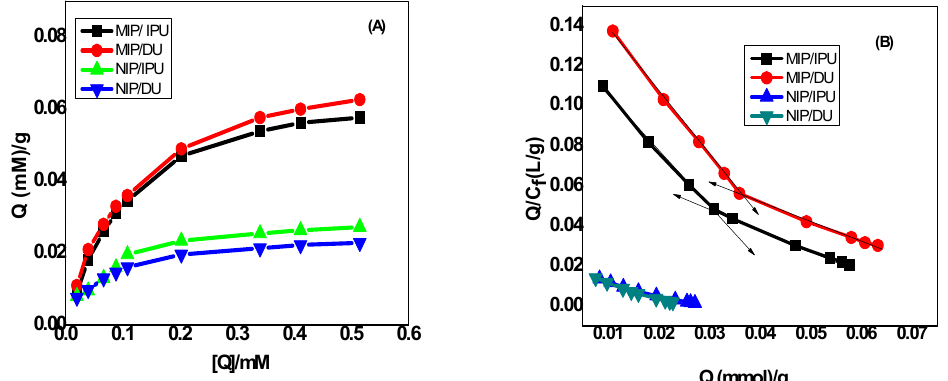
Figure 3. Binding isotherm ( A ) and Scatchard plot ( B ) for both isoproturon (IPU)- and diuron (DU)-imprinted polymers. Q = herbicide bound to 20.0 mg of the corresponding polymer; temperature = 25 °C; volume = 10.0 mL; binding time = 12 h.